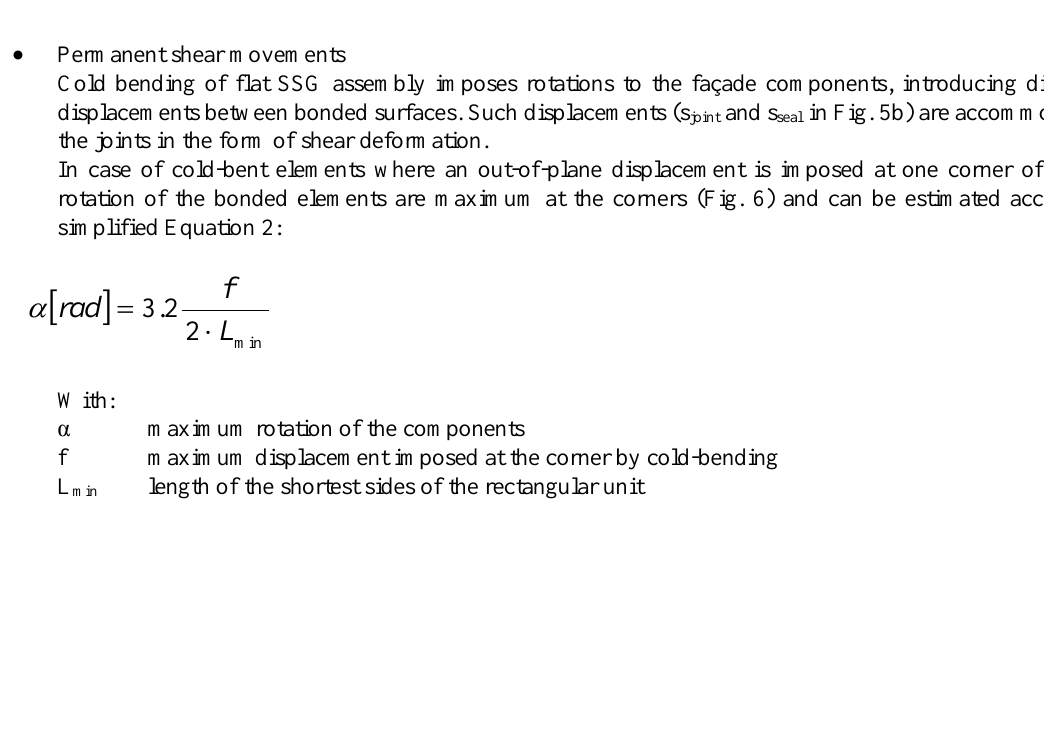
Fig. 4 Dummy load applied at unit corner and linear stress